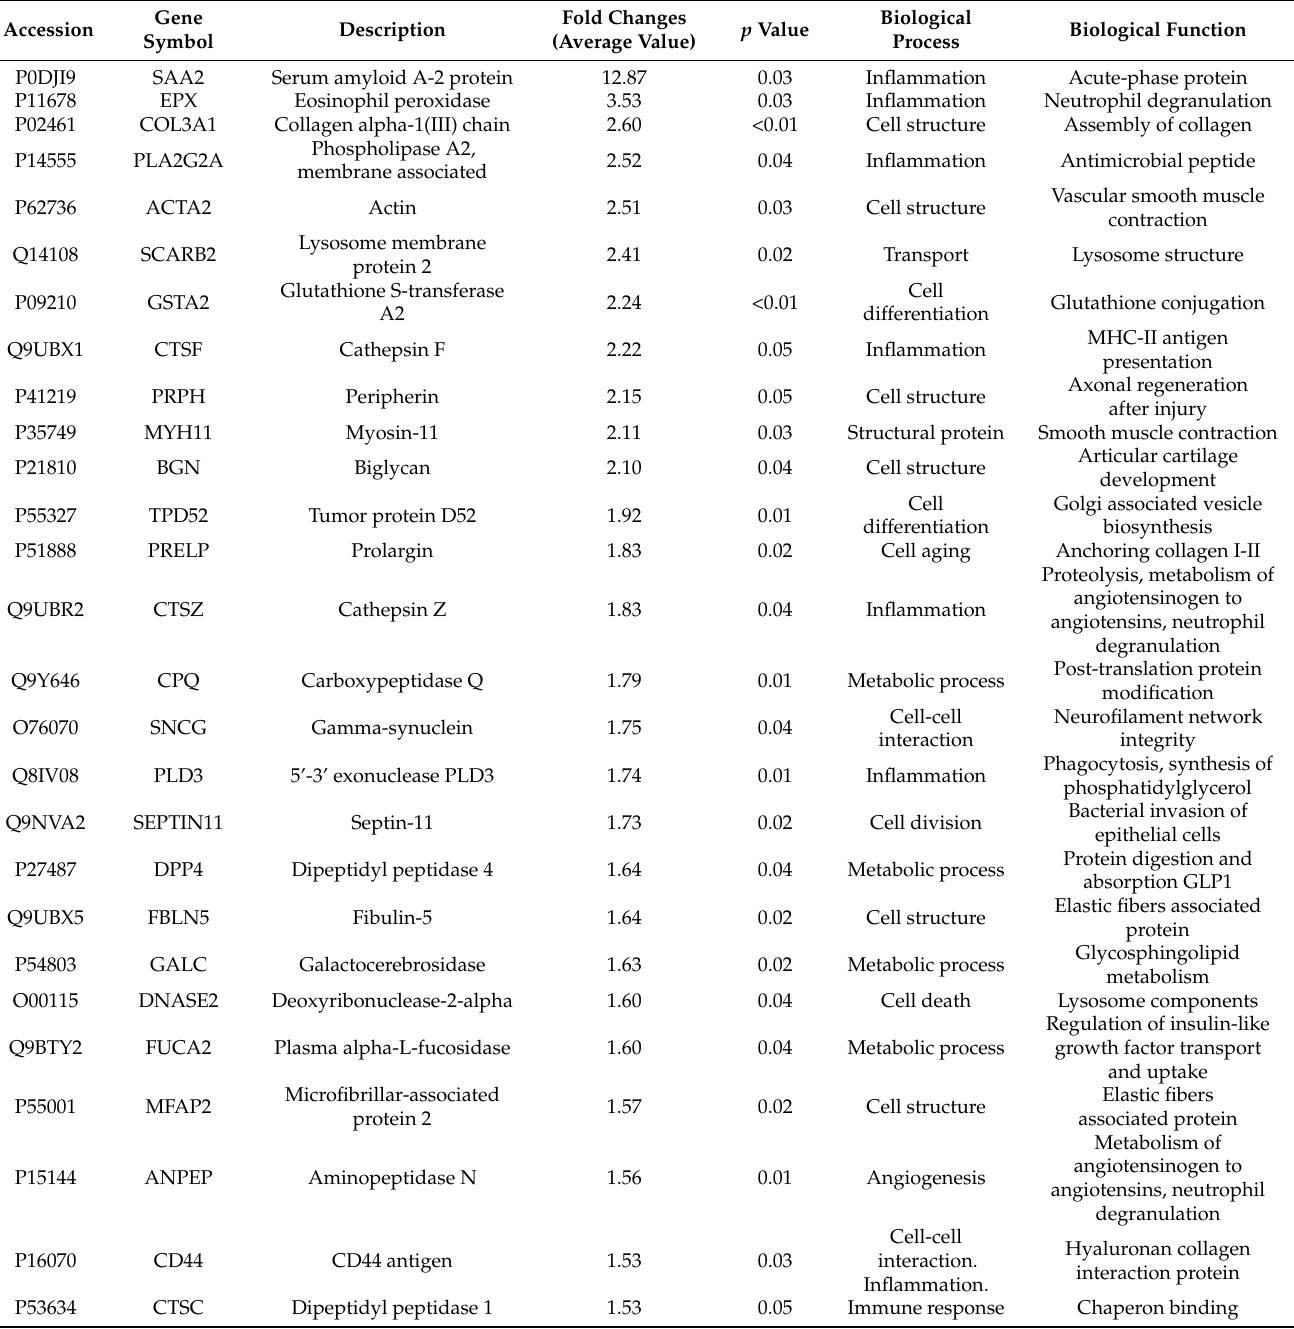
Table 2. List of proteins differentially expressed in the liver grafts of patients developing early AKI compared to liver grafts of patients with uneventful